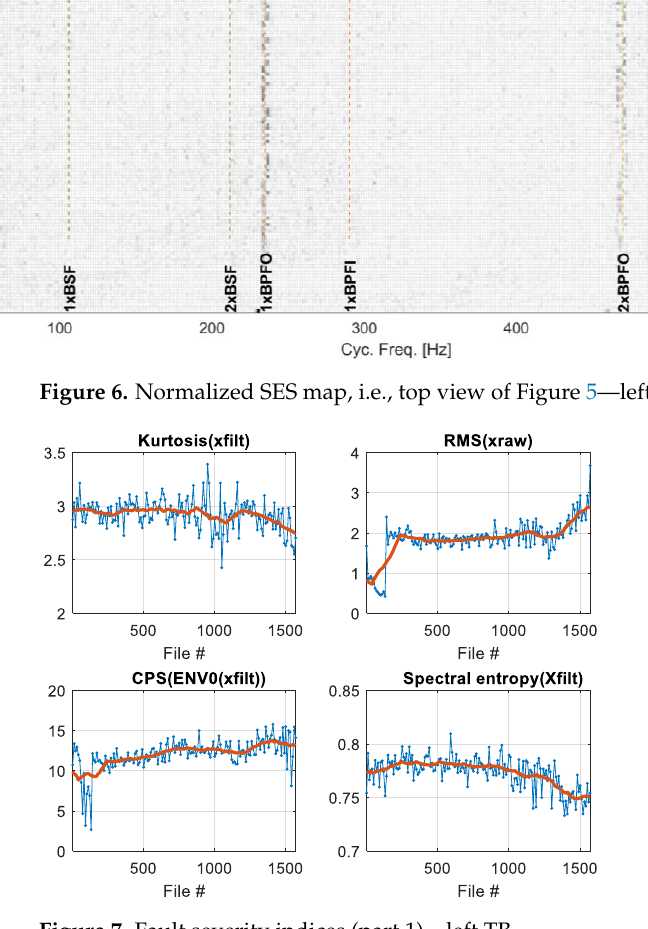
Figure 7. Fault severity indices (part 1)—left TB.